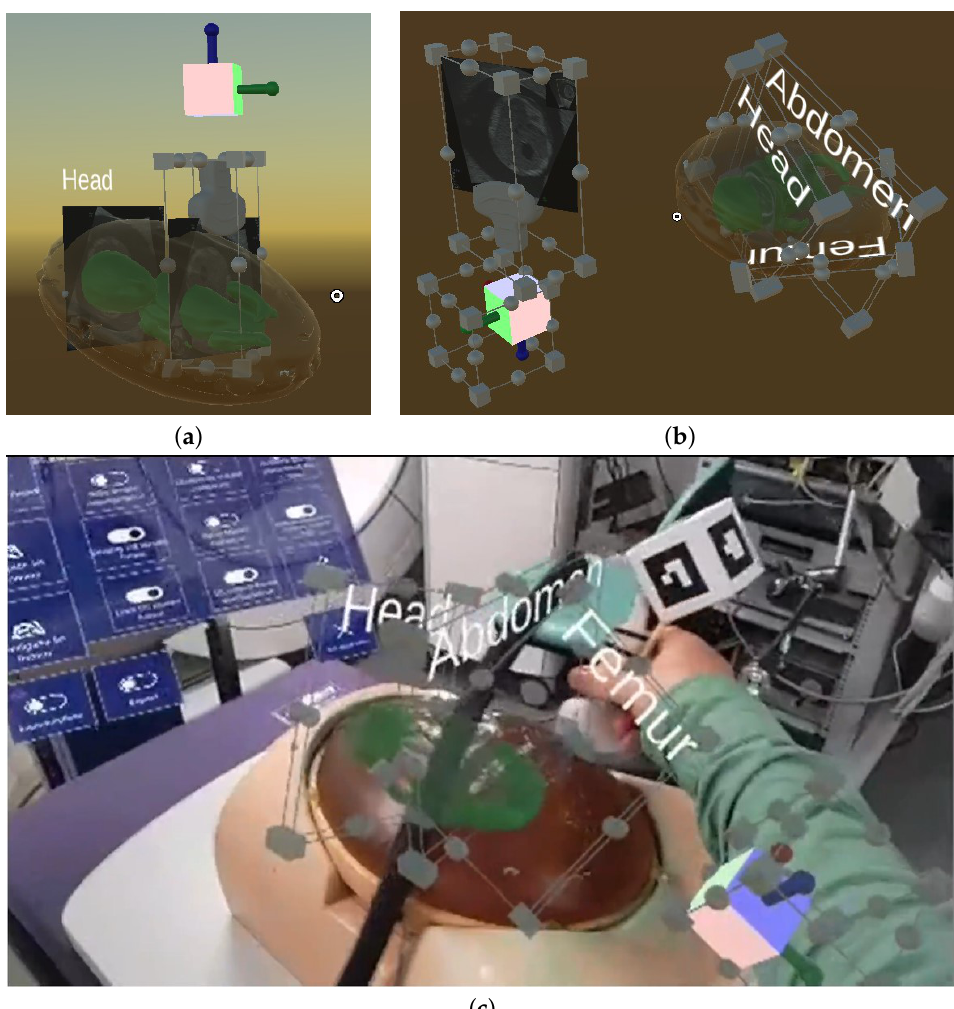
Figure 4. Hologram alignment options: two options of a standard manual plane definition: ( a ) placement of new standard planes via the US probe; ( b , c ) adjustment of already existing standard planes whose coordinates have been loaded via a .csv file—( b ) Unity concept and ( c ) HoloLens 2